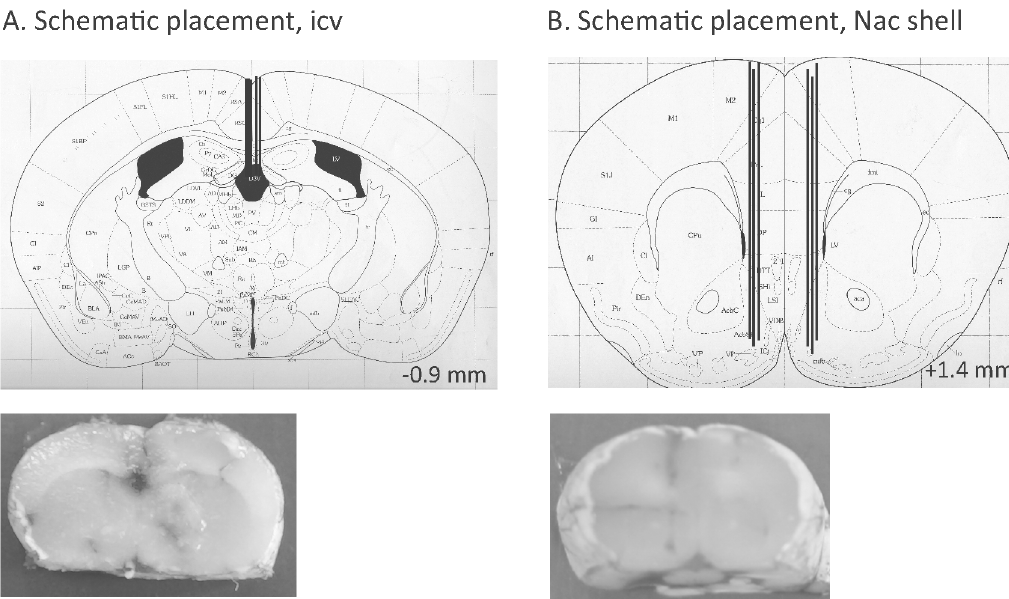
Fig 1. Schematic illustrations of placements. (A) A coronal mouse brain section showing five representative guide cannula placements (illustrated by vertical lines) aiming at the third ventricle (icv) [25]. In addition, a slice from mouse brain show one representative placement of a guide cannula in the third ventricle (B) A coronal mouse brain section showing six representative probe or guide cannula placements (illustrated by vertical lines) in the nucleus accumbens (NAc) shell [25]. Moreover, a slice from a mouse brain shows one representative placement in the NAc shell. For each brain section only a few representative placements are illustrated, but all other placements targeted the third ventricle or were within the NAc shell. Placements outside these areas were not included in the statistical analysis. The number given in the brain section indicates millimeters anterior (+) or posterior (-) from